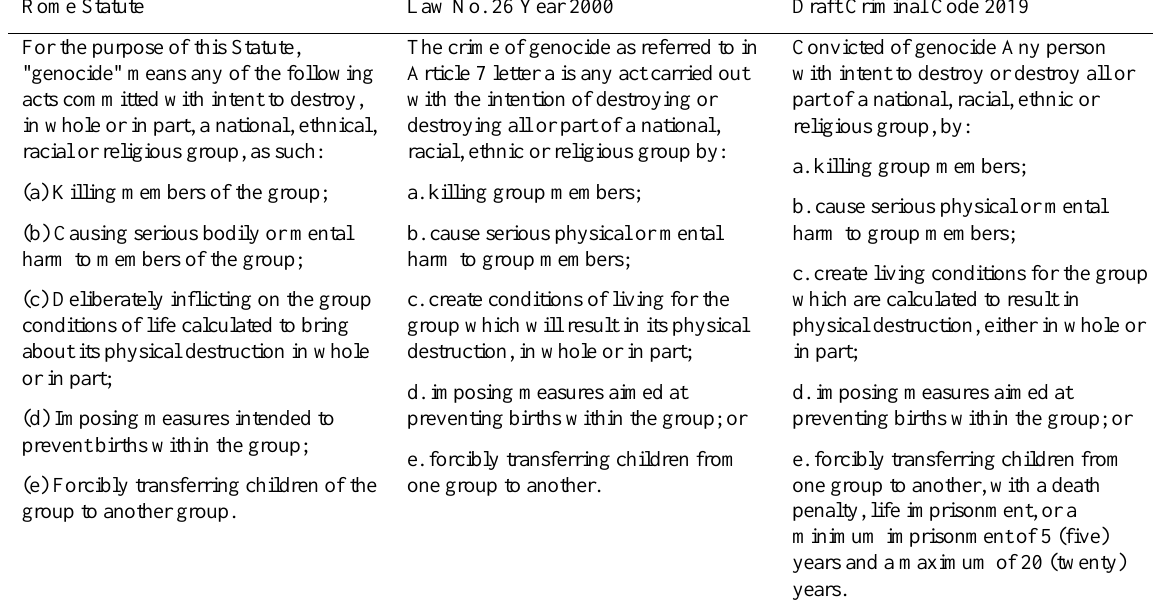
Table 1: The different formulations of the crime of genocide in the Rome Statute, Law no. 26 of 2000, and the 2019 RKUHP Rome